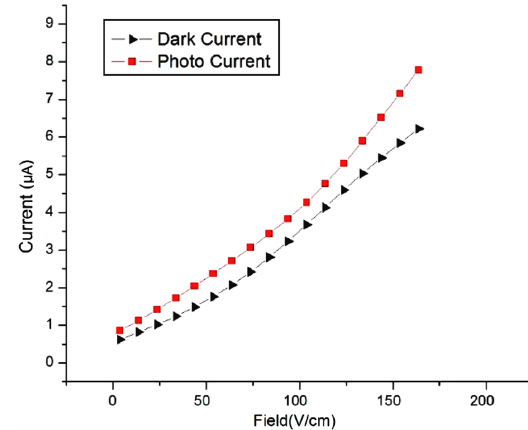
Figure 10. Photoconductivity study of CuSe thin